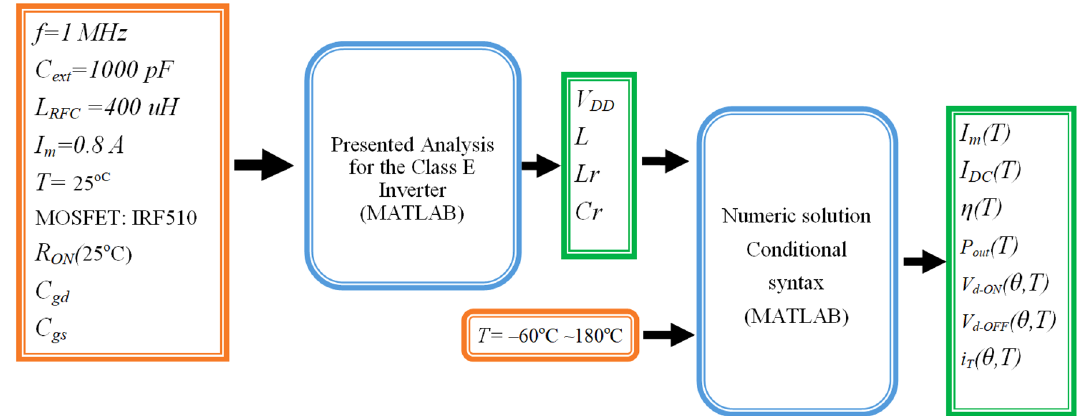
Figure 13. Block diagram of the Presented Design for the Class E Inverter at 25